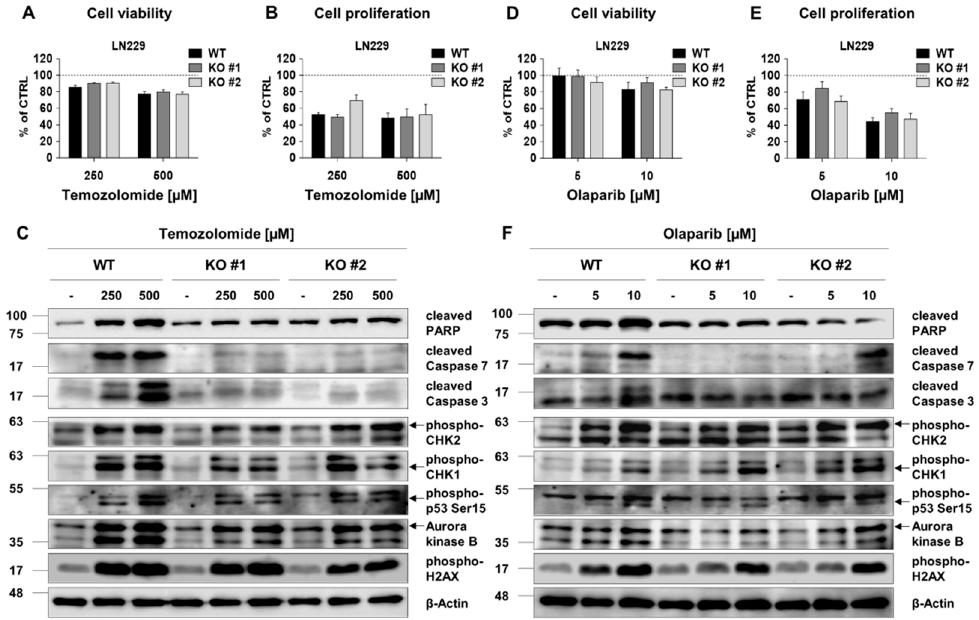
Figure 7. RECQL4 depletion does not sensitize LN229 glioma cells to temozolomide or olaparib. Analyses of viability and proliferation of WT and RECQL4-deficient LN229 cells exposed for 72 h to TMZ (250 and 500 µM) ( A,B ) or olaparib (5 and 10 µM) ( D,E ). The results were normalized to control cells (CTRL) and represent means ± SEM ( n = 4). Statistical significance was determined by RM two-way ANOVA, with followed by Tukey’s HSD post hoc test. Representative immunoblots show the levels of cell death, proliferation and cell cycle proteins after the treatments of WT and RECQL4 KO LN229 cells with TMZ ( C ) or olaparib ( F ). β -Actin was used as a loading